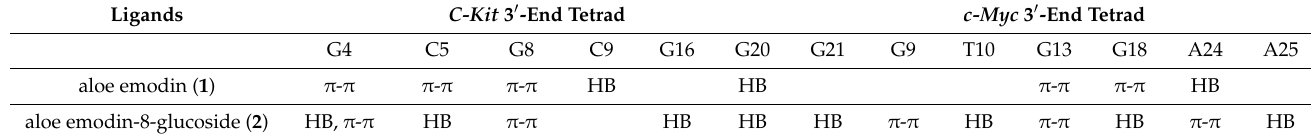
Table 1. Table summarizing the key interactions observed in the C ‐ Kit /Ligands and c ‐ Myc /Ligands complexes as obtained by molecular modeling. The table shows the nucleotides involved in the interactions together with the type of interactions (HB = Hydrogen Bond).